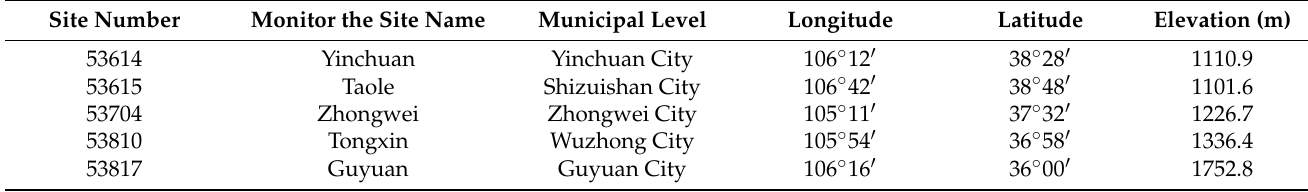
Table 1. Basic information of each monitoring station in Ningxia.